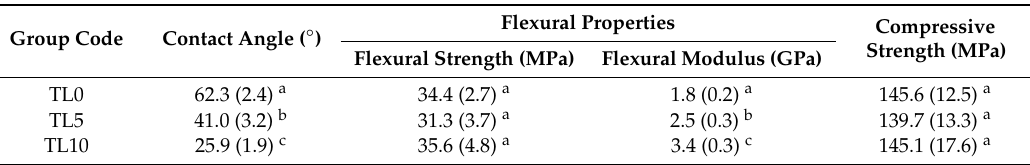
Table 1. Contact angles and mechanical properties of three TheraCal LC materials (means (standard deviations), n = 6/group).